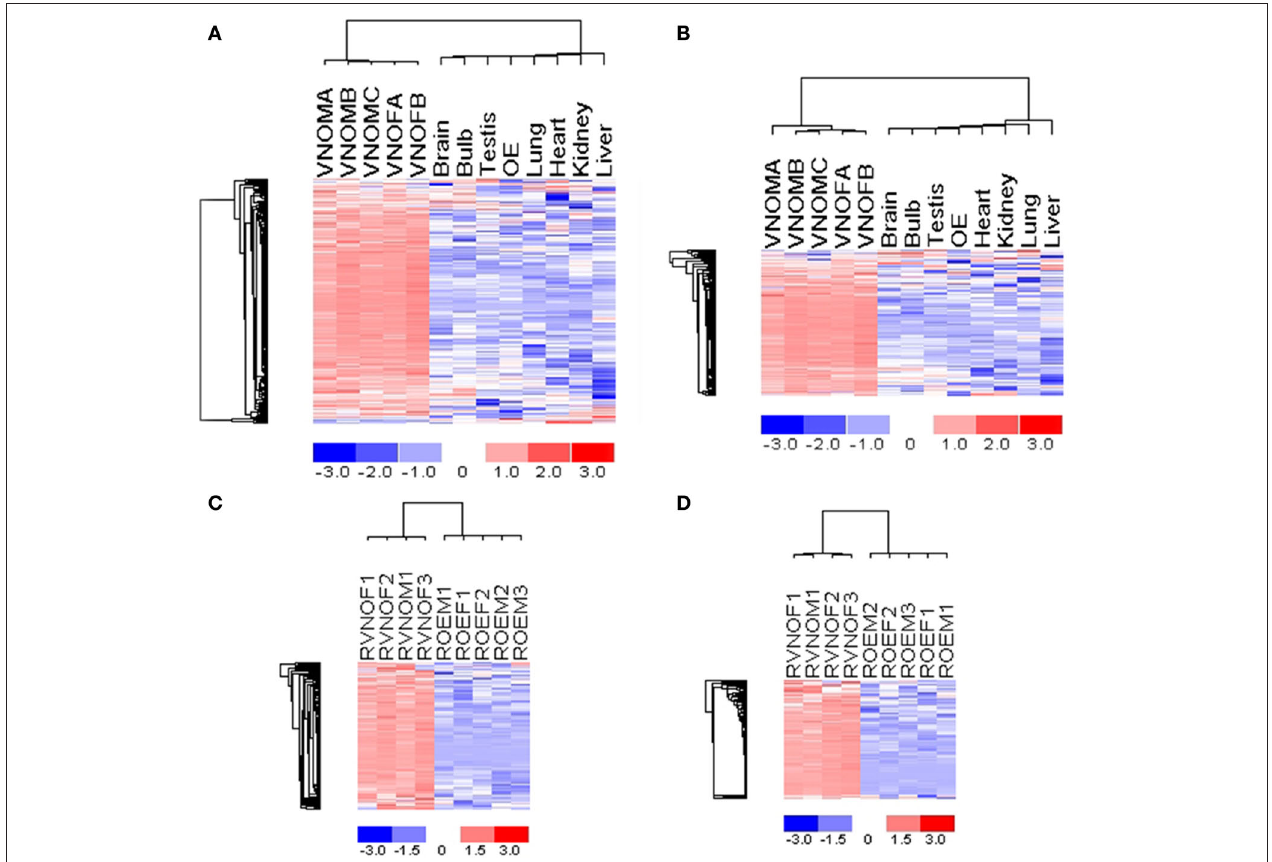
lower-than-mean values. The dendrogram on the left shows clustering of genes, and the top dendrogram shows clustering of samples based on the expression data. Genes with at least two present calls and high variation across samples are chosen for the clustering analysis and are shown in the figure. In (A) , 179 probe sets representing 168 mouse V1R genes are shown; in (B) , 107 probe sets representing 98 mouse V1R genes are shown; in (C) , 108 probe sets representing 108 rat V1R genes are shown; in (D) , 87 probe sets representing 87 rat V2R genes are